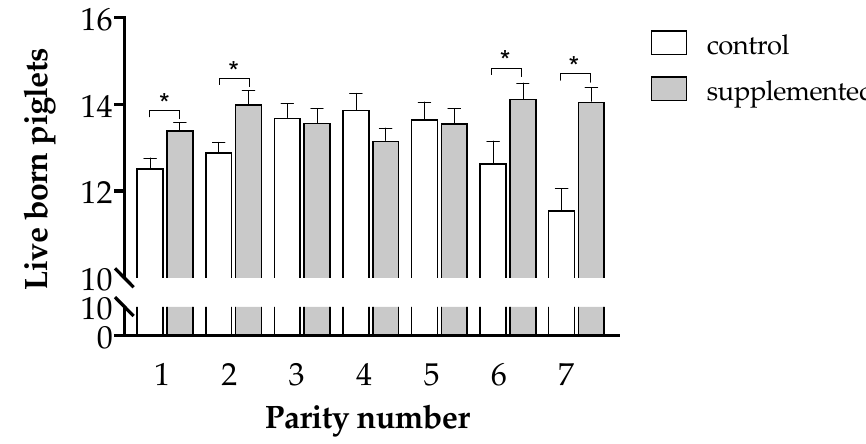
Figure 3. Mean values (± S.E.M.) of living piglets according to parity in sows treated or not with herbal antioxidants. Asterisks denote significant differences between groups ( p < 0.05).